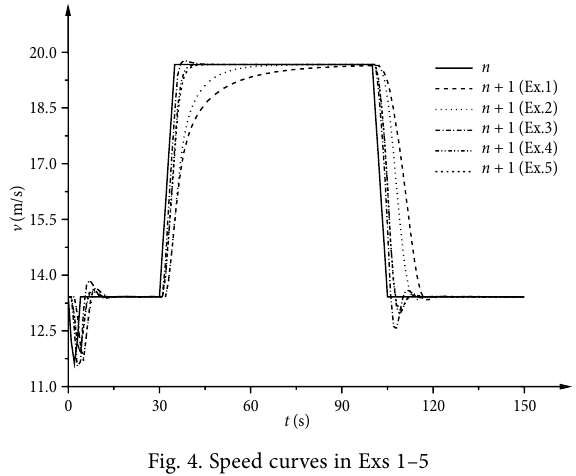
Fig. 4. Speed curves in Exs 1–5